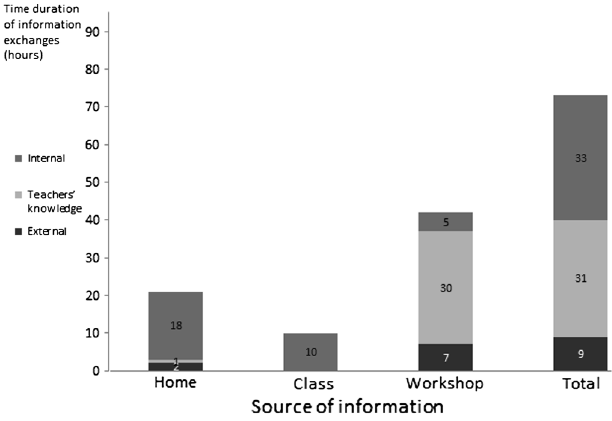
FIG. 4. Workshop B (maximal guidance): Information inter- changes by source of information and location.